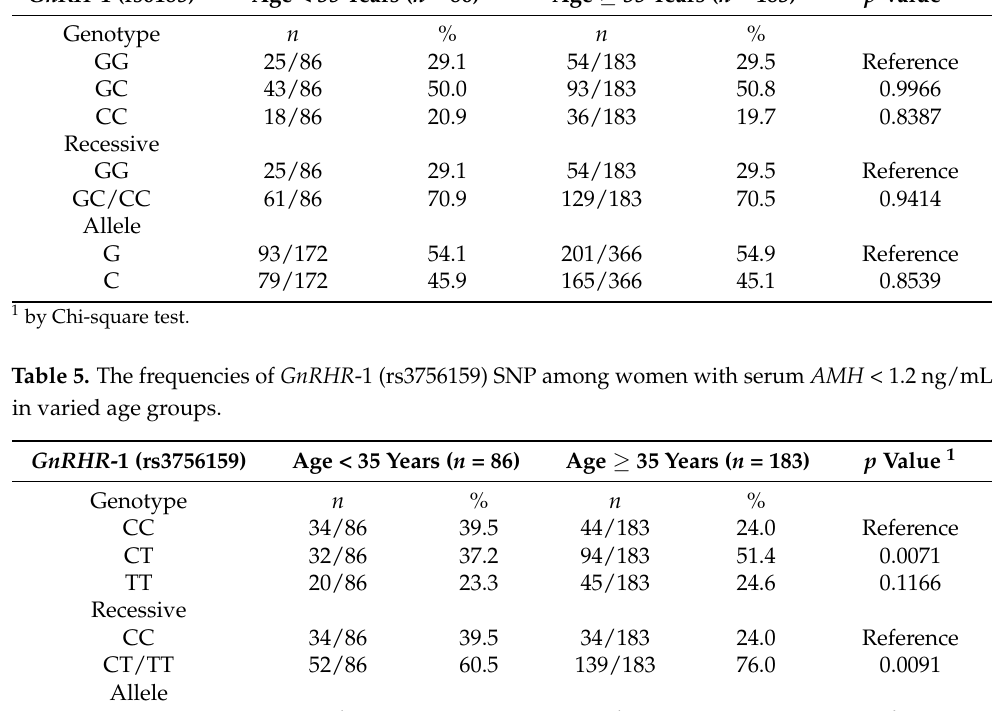
Table 6 demonstrated the patients’ clinical parameters with the varied genotypes of GnRHR SNP (rs3756159). Among the clinical parameters related to ART cycles, only the